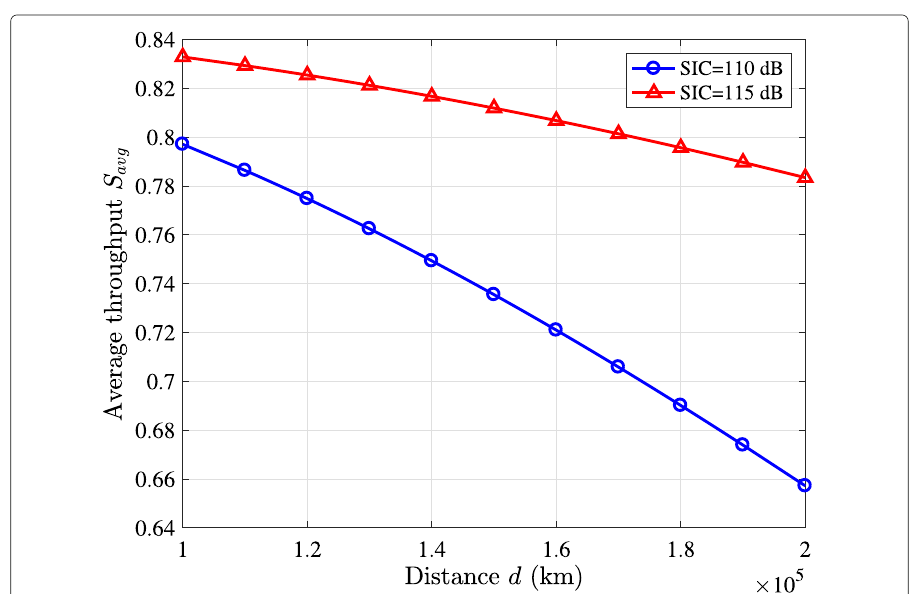
Fig. 7 Average throughput of FDQ-LoRa, in the space-air-ground